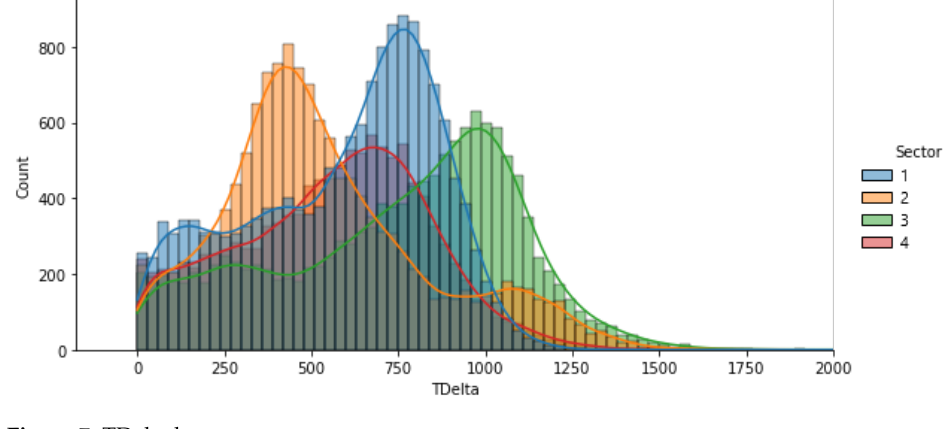
Figure 7. TDelta by